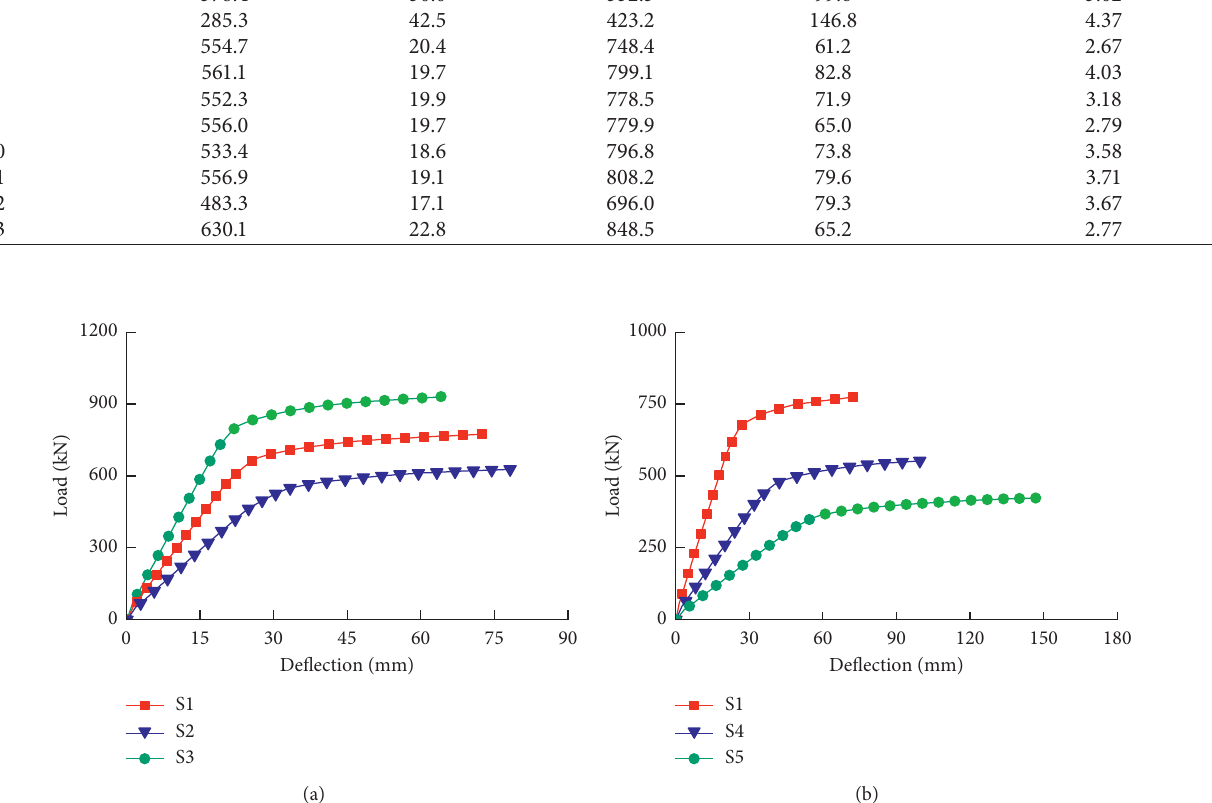
Figure 8: Load vs. midspan deflection with different span-to-depth ratios. (a) Effect of CSW depth. (b) Effect of beam